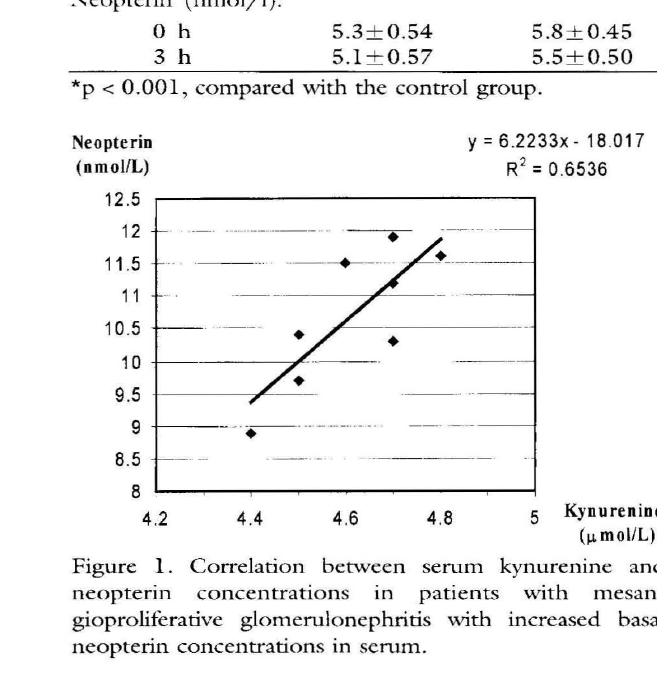
Figure 1. Correlation between serum kynurenine and neopterin concentrations in patients with mesan gioproliferative glomerulonephritis with increased basal neopterin concentrations in